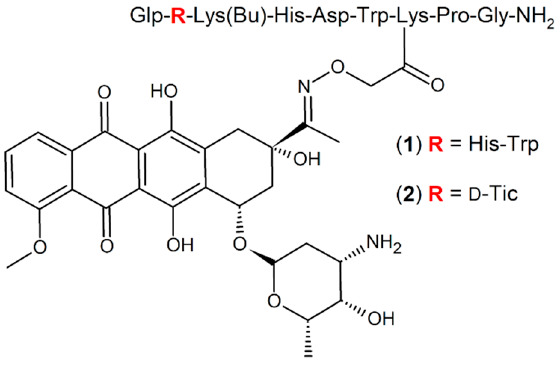
Figure 1. Structure of GnRH-III-Dau conjugates 1 and 2 .